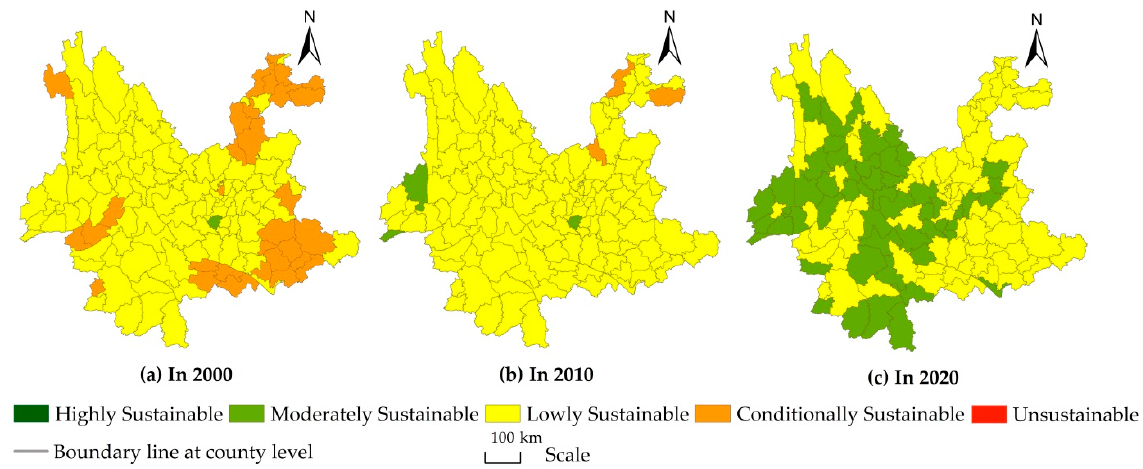
Figure 5. Social acceptability evaluation of land use from 2000 to 2020.